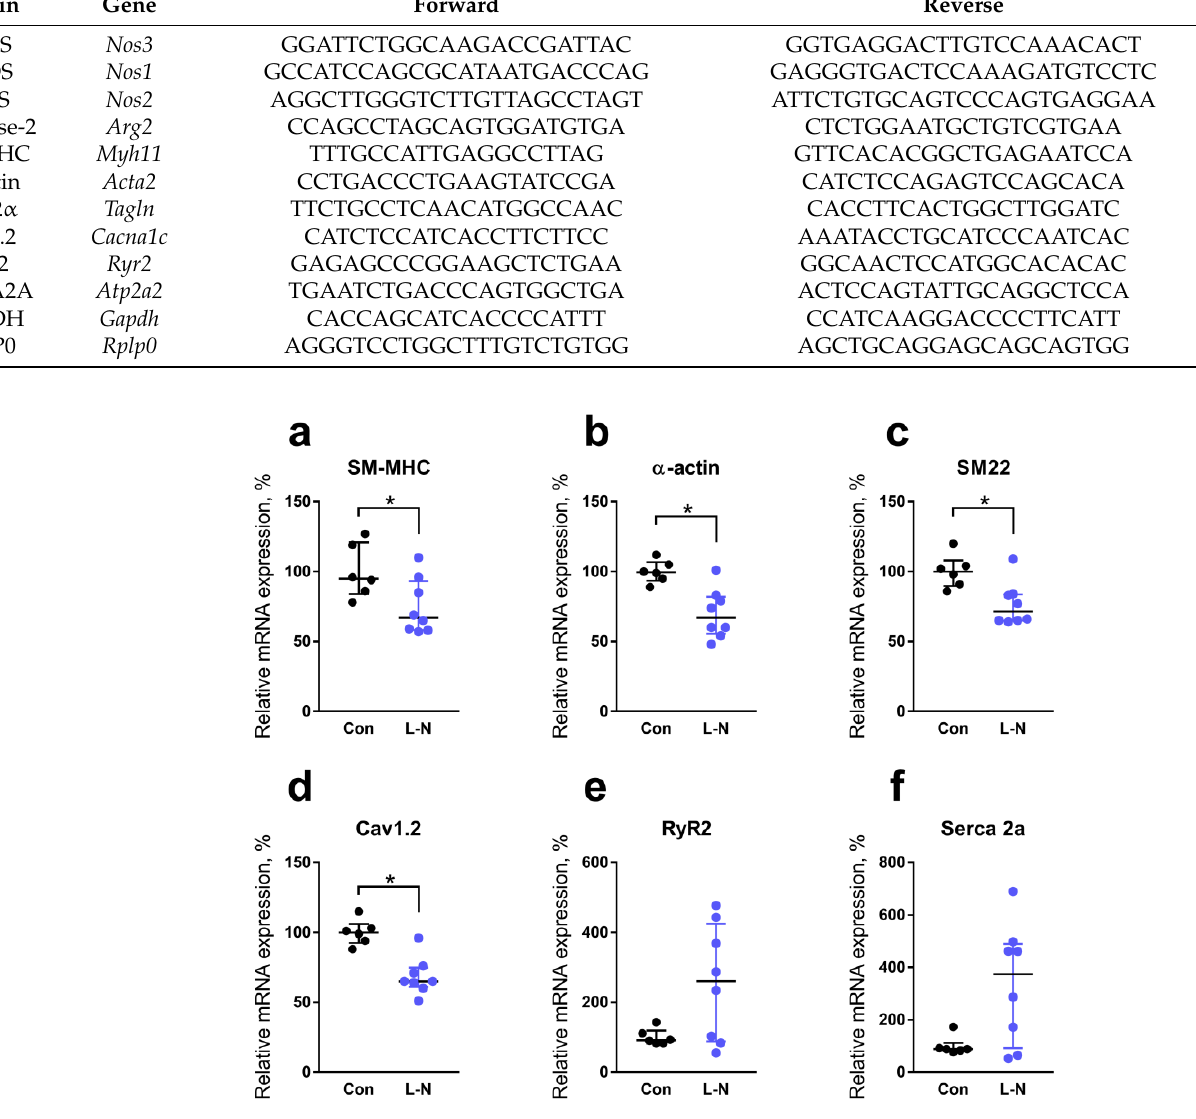
Figure 4. Relative mRNA expression levels of genes encoding proteins typical of the smooth muscle cell contractile phenotype in the aorta of 1-day-old rat pups. Relative mRNA content of smooth muscle myosin heavy chain isoform (SM-MHC, ( a ), α -actin ( b ), SM22 α ( c ), L-type Ca 2+ channels (Cav1.2, ( d )), ryanodine receptor 2 (RyR2, ( e ) or Serca2a ( f ) in the aorta of control or L-NAME (L-N) rats. The number of tissue samples per group: control—6; L-NAME—8. Data are presented as median and interquartile ranges. * p < 0,05 (Mann-Whitney test).